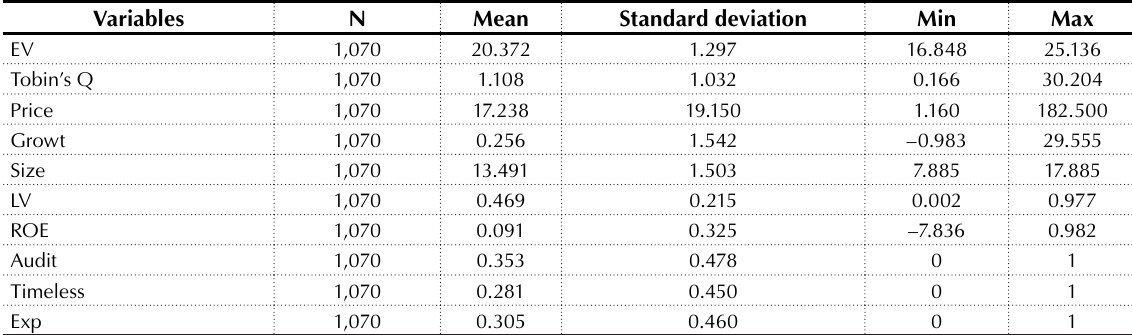
Table 2. Statistics description for the five-year averages, from 2012 to